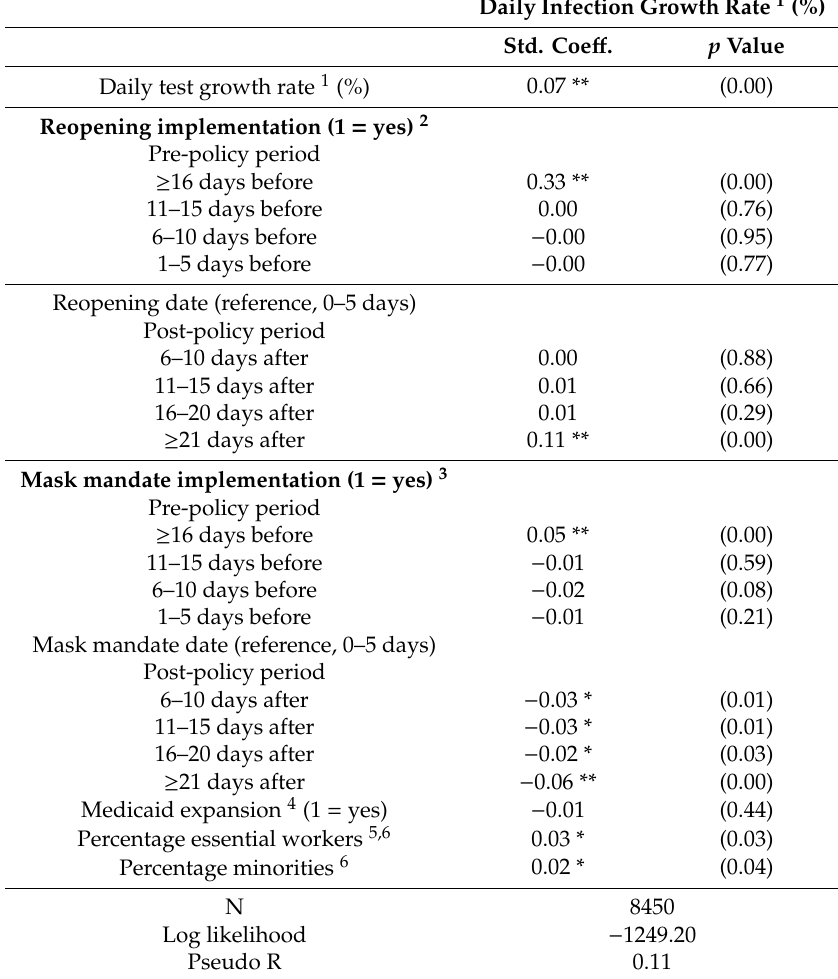
Table A1. COVID-19 US state policies: reopening and mask mandates; event study model results; March through August 2020 (standardized coe ffi cients). Daily Infection Growth Rate 1